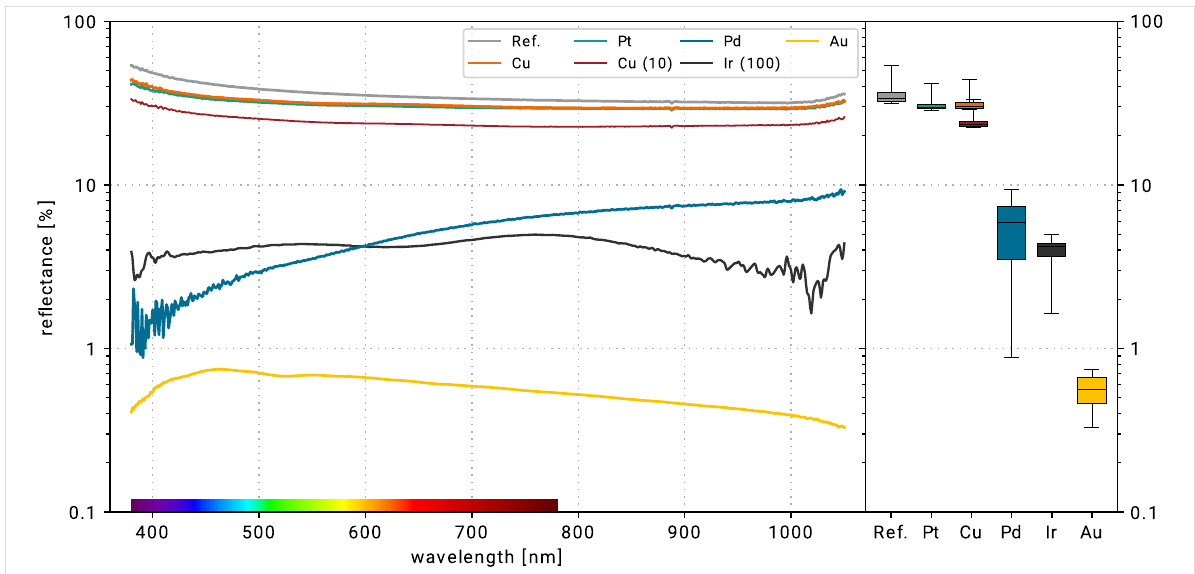
ever, this structure also suffers from low stability. The surface is affected by several fractures. This can be seen in Figure